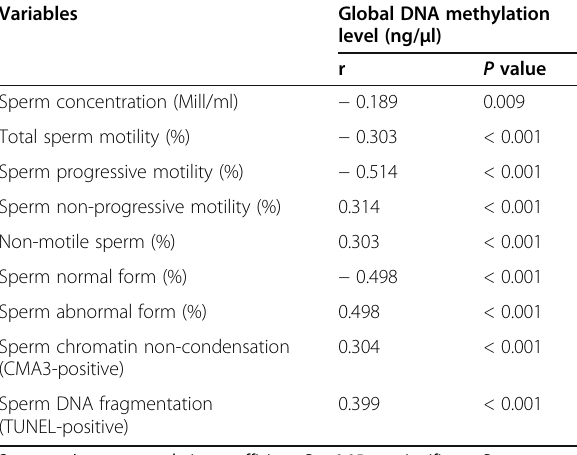
Table 4 Correlation between the status of global DNA methylation and semen parameters Variables